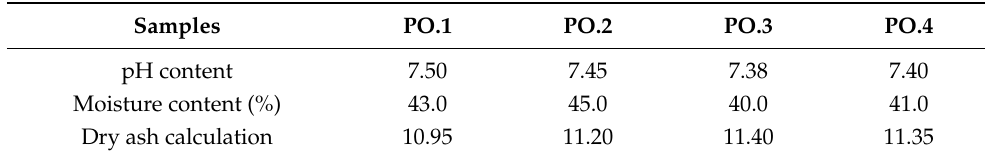
Table 3. Cumulative table showing the laboratory tests of the investigated Posidonia oceanica balls and dry ash